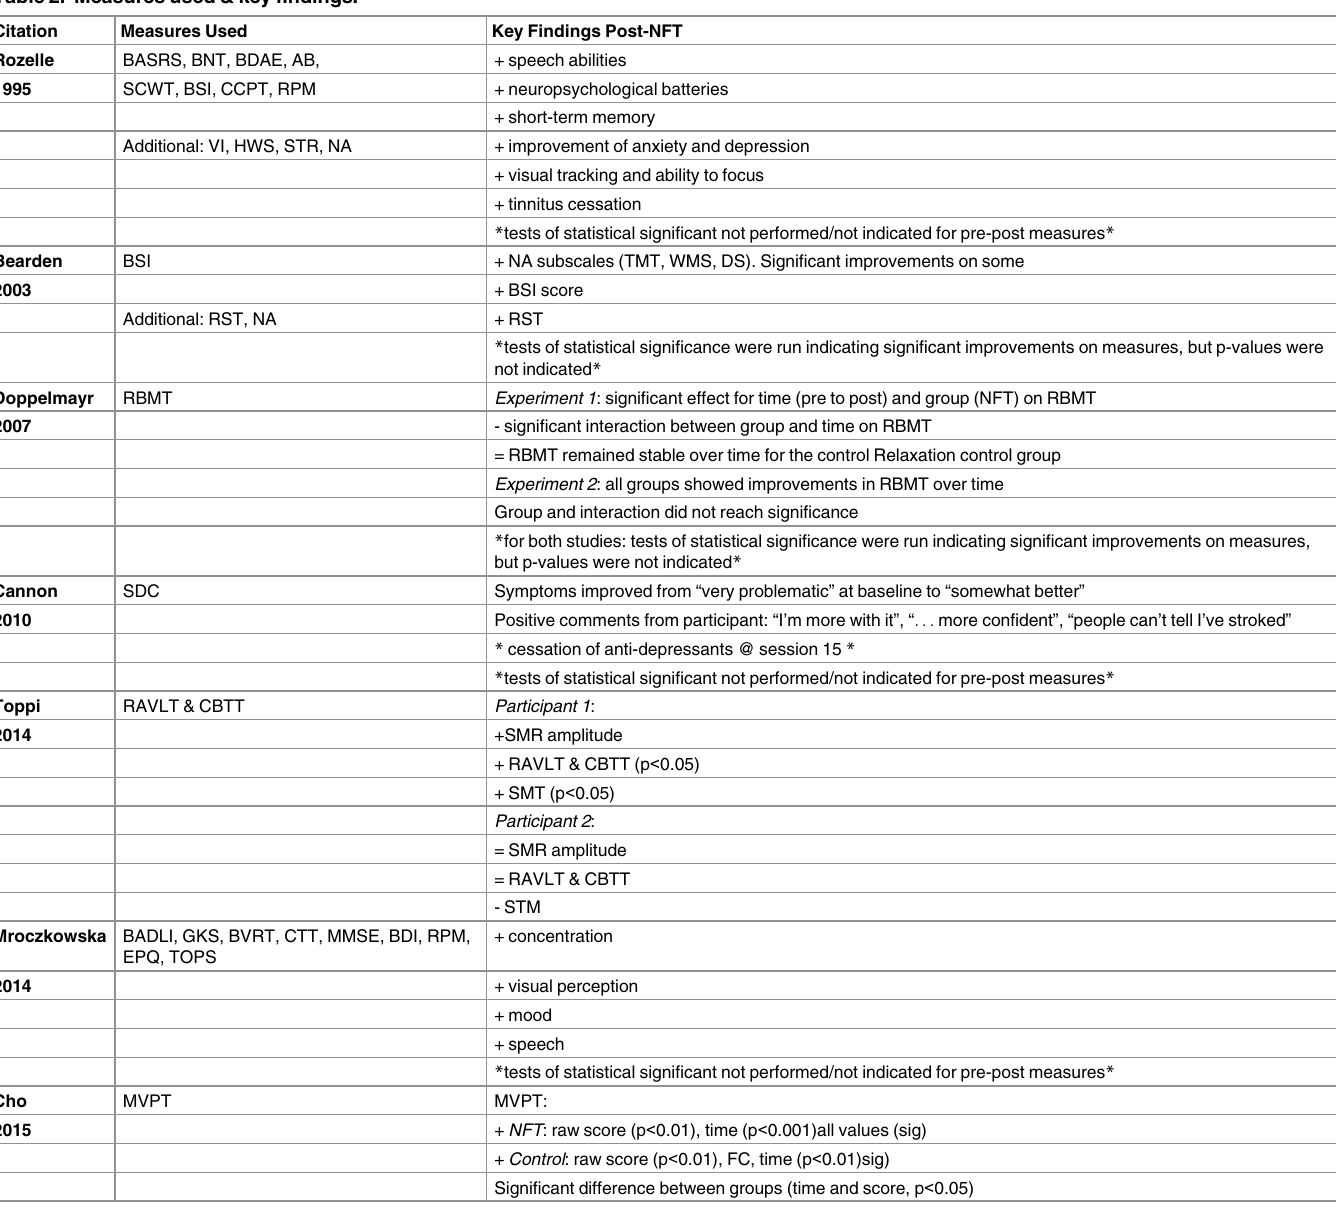
Table 2. Measuresused & key